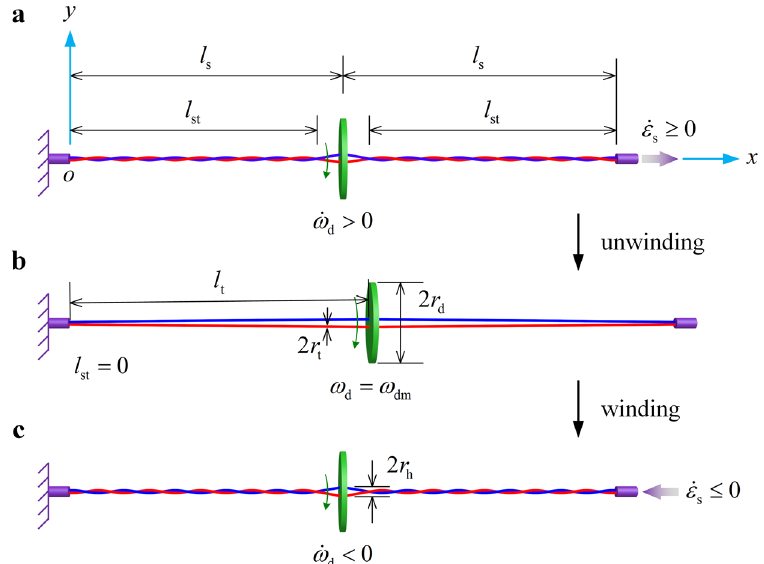
Figure 1. Schematic for theoretical model. Structural parameters of the thread–disk system are illustrated. The periodic rotation of the system is divided into to two stages: unwinding (from ( a ) to ( b )) and winding (from ( b ) to ( c )). The Cartesian coordinate system xoy is introduced, where the origin o is located at the clamped end of the string, and x and y axes are along and perpendicular to its length direction, respectively. The lengths of the string and its twisted section are denoted as l s and l st , respectively. The length of the threads is denoted as l t . The radii of the threads and the disk are denoted as r t and r d , respectively. The distance between the center of the disk and the holes is r h